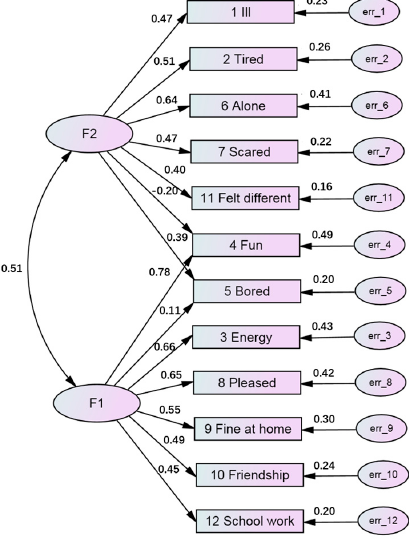
Figure 2. Path diagram of con fi rmatory factor analysis with standardized estimates (N = 1252). The left ellipses represent factors F1 and F2, the right ellipses (err_1, err_2, etc.) represent measurement errors of corresponding input variables (1 Ill, 2 Tired, etc.). The numbers on the left one-sided arrows (0.47, 0.51, etc.) are estimates of factor weights and 0.51 is the correlation between F1 and F2. The numbers on the right arrows (0.23, 0.26, etc.) are the squared multiple correlations, which indicate a proportion of variable variance accounted for by factor F1 and/or factor F2.).